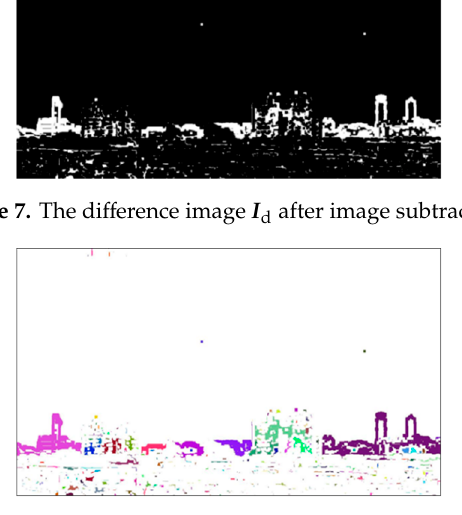
Figure 8. The image I dl after labeling.